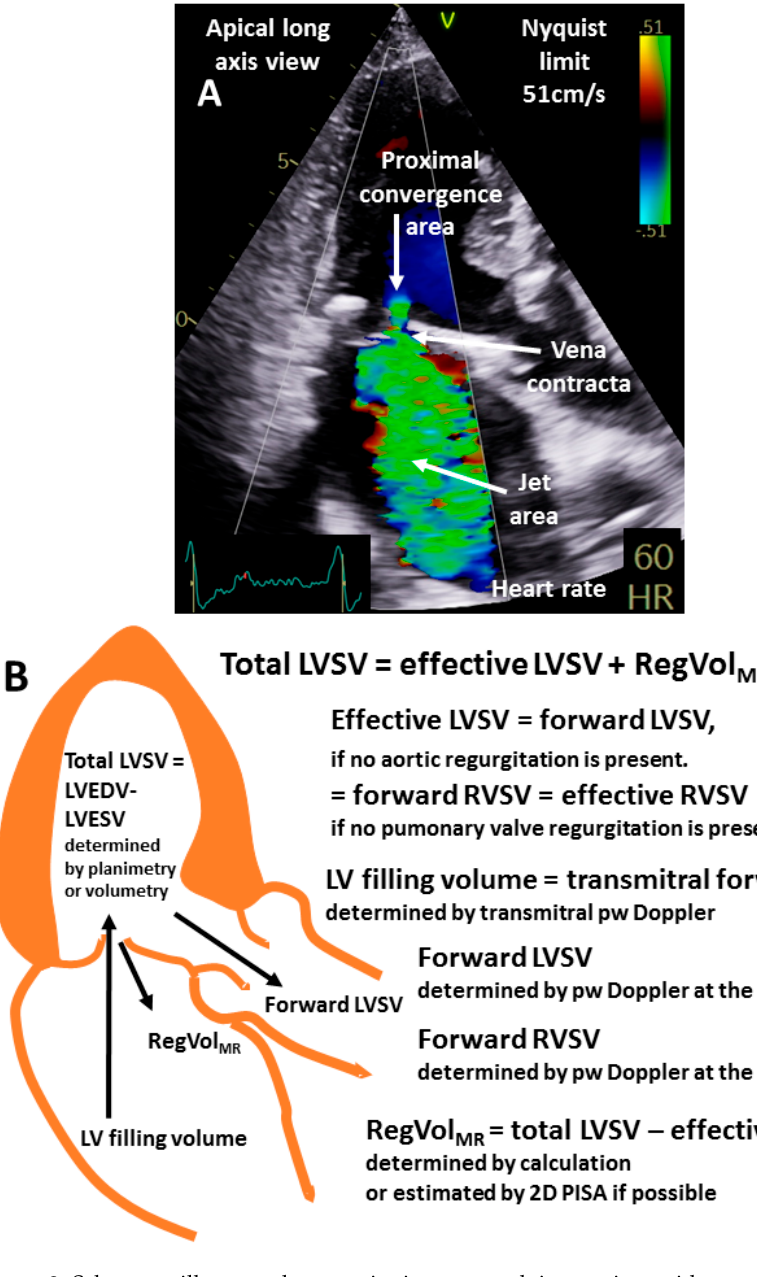
Figure 2. Scheme to illustrate the quantitative approach in a patient with pure mitral regurgitation (MR). The proximal convergence area, the vena contracta, and the jet area displayed in an apical long-axis view is shown in ( A ). In ( B ), a corresponding scheme is presented to explain the left ventricular (LV) and right ventricular (RV) volumes and the respective modalities for estimation by echocardiography. LVSV = LV stroke volume, RegVol MR = regurgitant volume through the mitral valve, RVSV = RV stroke volume, pw = pulse wave, LVOT = left ventricular outflow tract, and RVSV = right ventricular outflow tract.